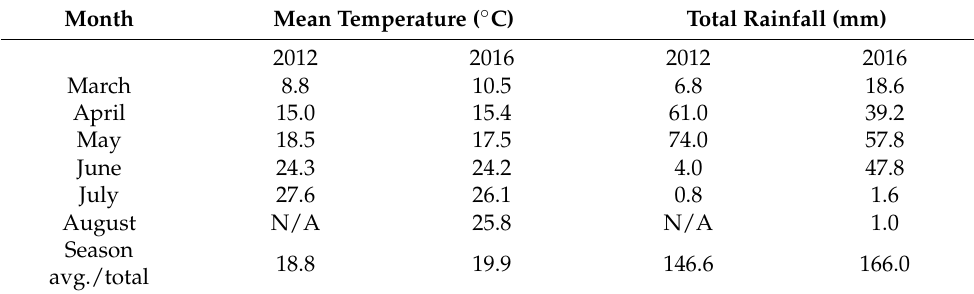
Table 1. Mean monthly temperature and total monthly rainfall in each growing season.